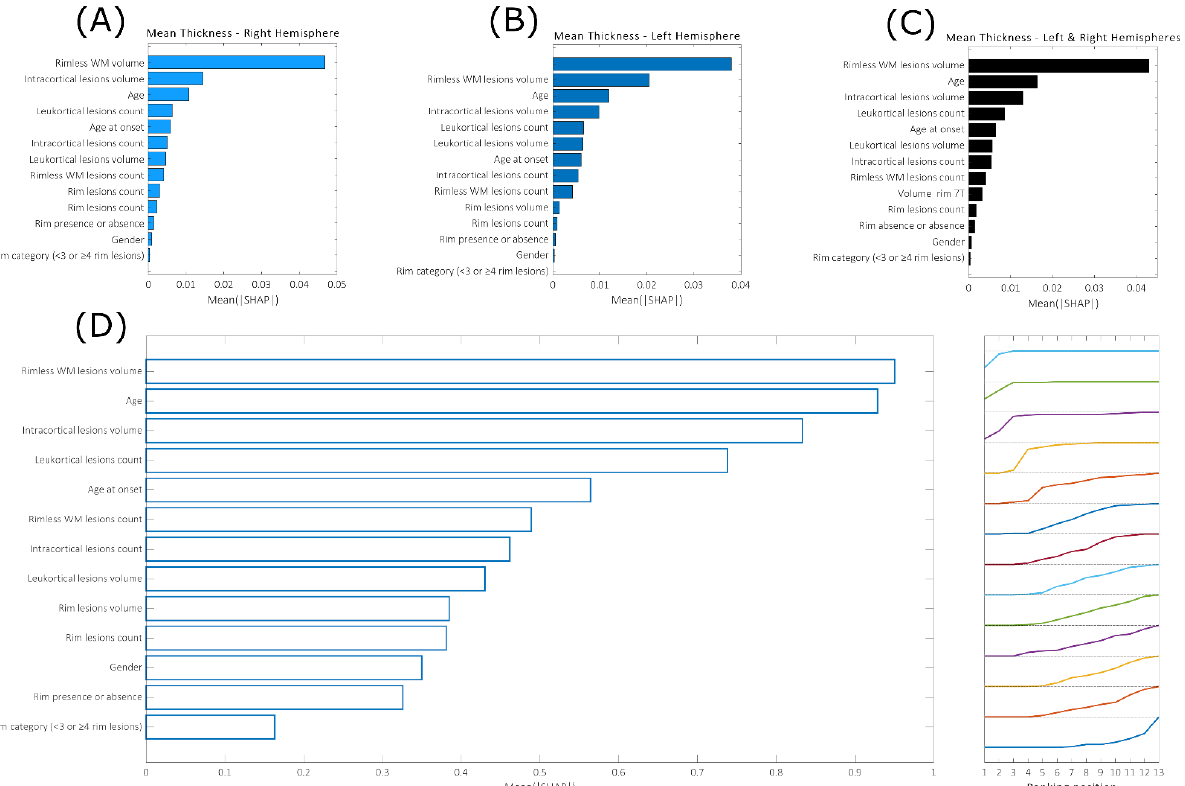
8 of 12 Table 3. Pearson’s correlation (r) coefficients and corresponding p values evaluated between the real